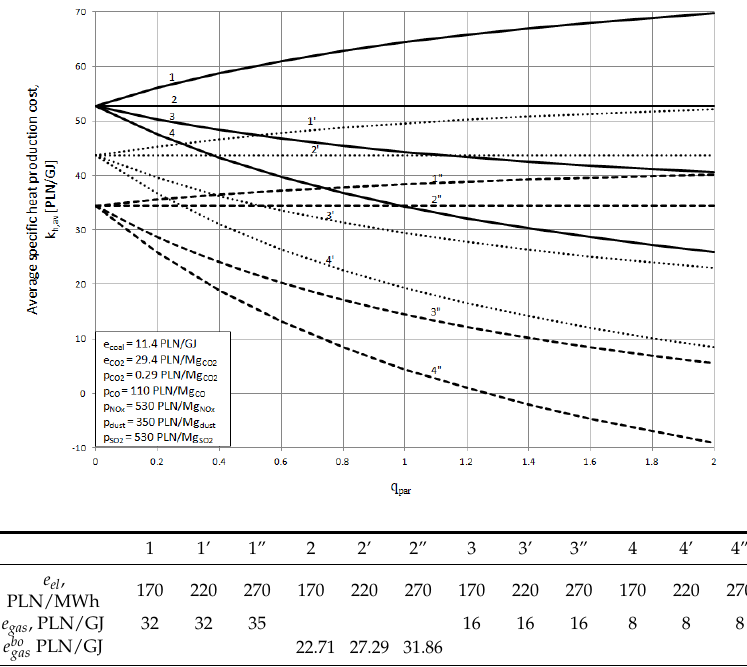
Figure 8. Average specific cost of heat production as a function of q par with the price of gas as a